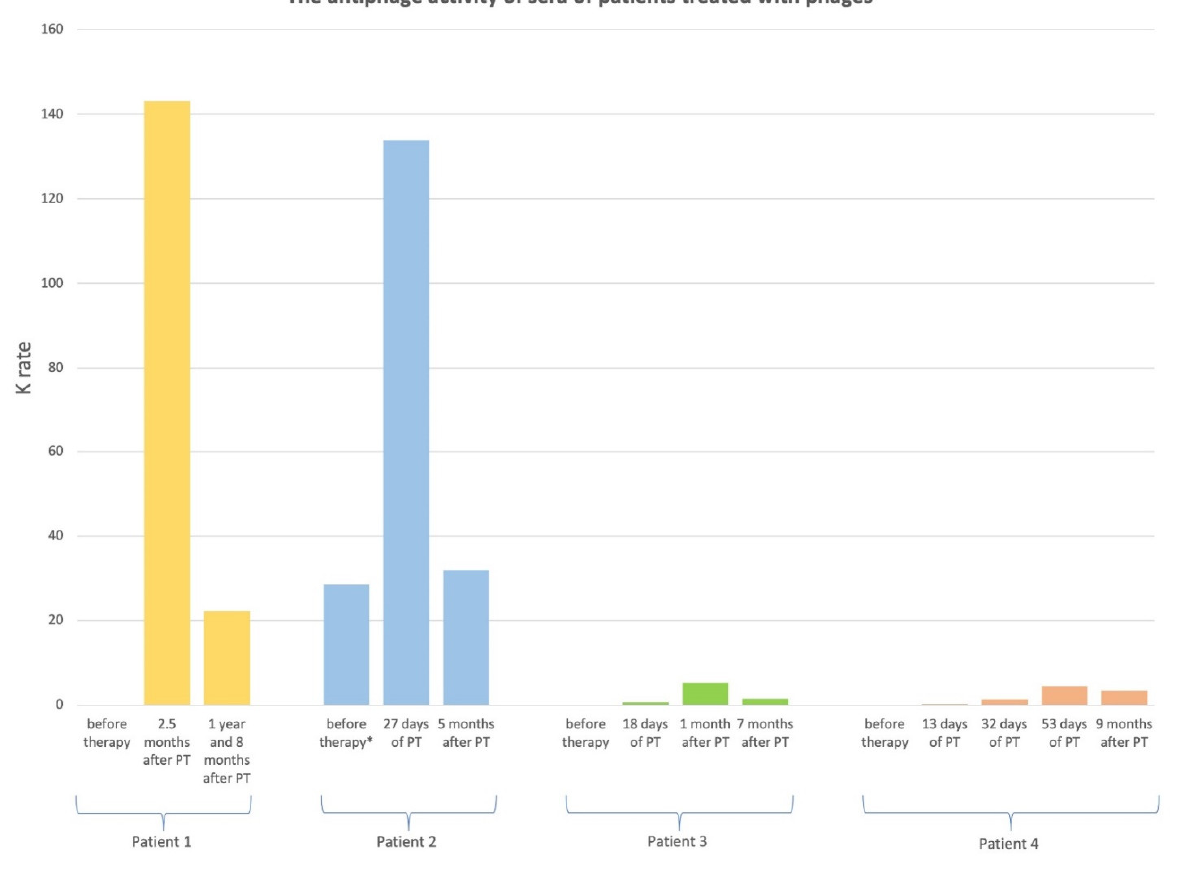
Figure 1. The antiphage activity of sera of patients treated with phages. Legend: PT—phage therapy; K: rate of phage inactivation; K < 5: low neutralization of phages; K = 5–18: medium neutralization of phages; K > 18: high neutralization of phages; * before the third PT cycle.